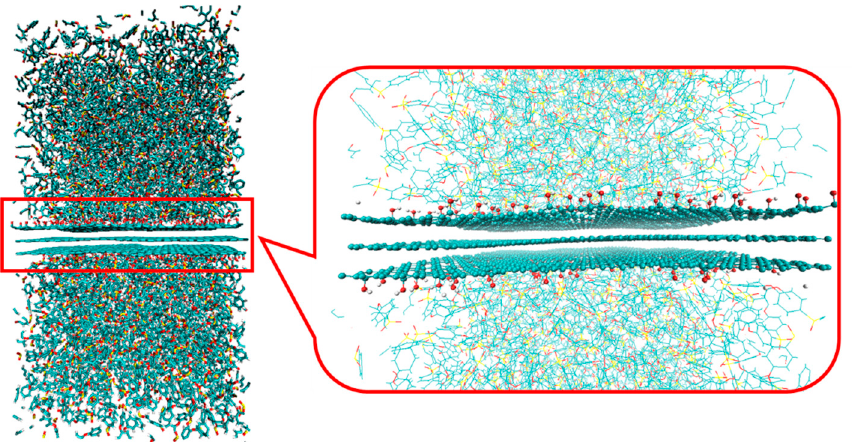
Figure 3. Snapshot of the composite model of PEI and graphene with –OH in the equilibrium state. The enlarged interface region and graphene sheets are highlighted in the right figure.